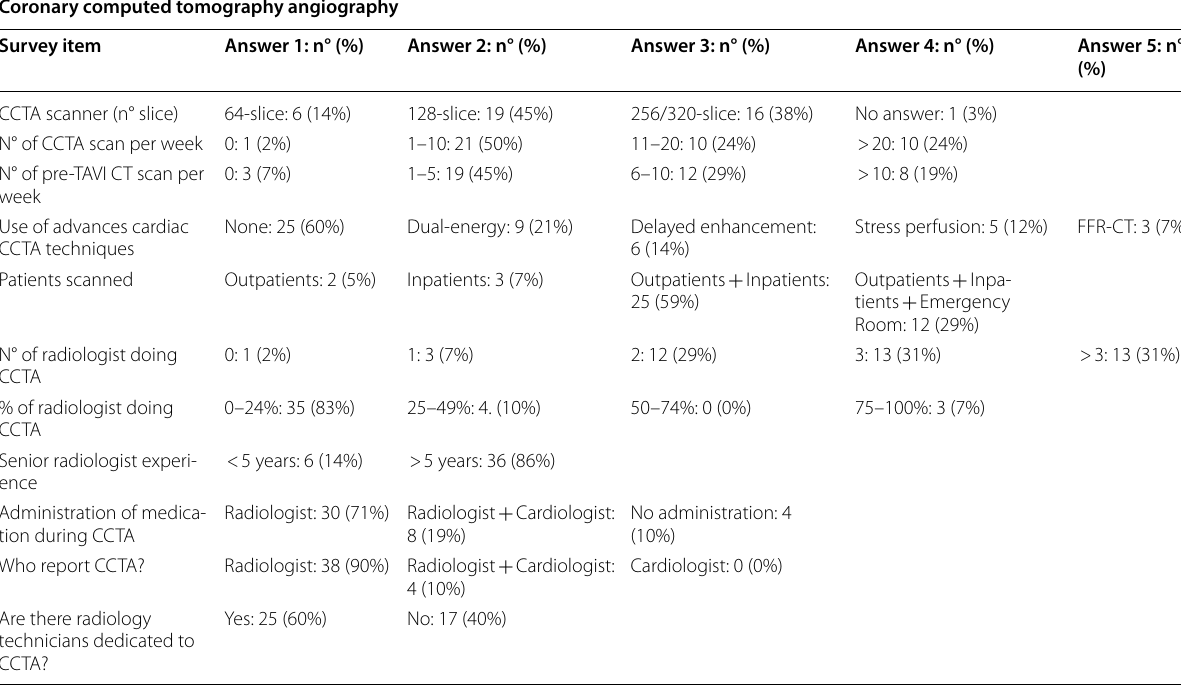
Table 1 Questions and answers on CCTA diagnostic